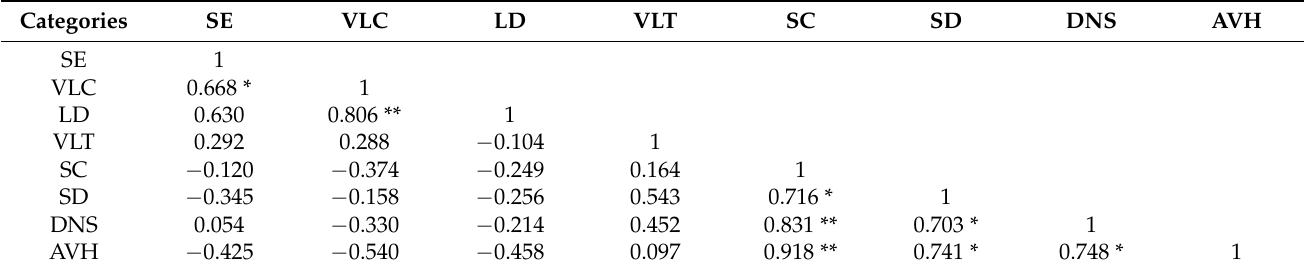
Table 1. Spearman’s correlation coefficient between the soundscape/landscape elements and sub- jective comfort levels at Laojundong Temple. Significant correlations are marked with (* p < 0.05) and (** p < 0.01).